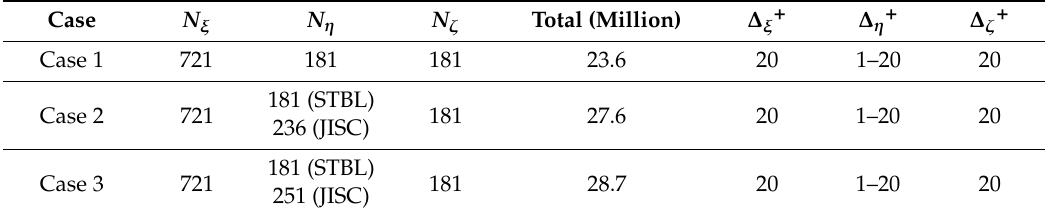
Table 3. Grid number in the computational domain and corresponding resolution in the focus region.